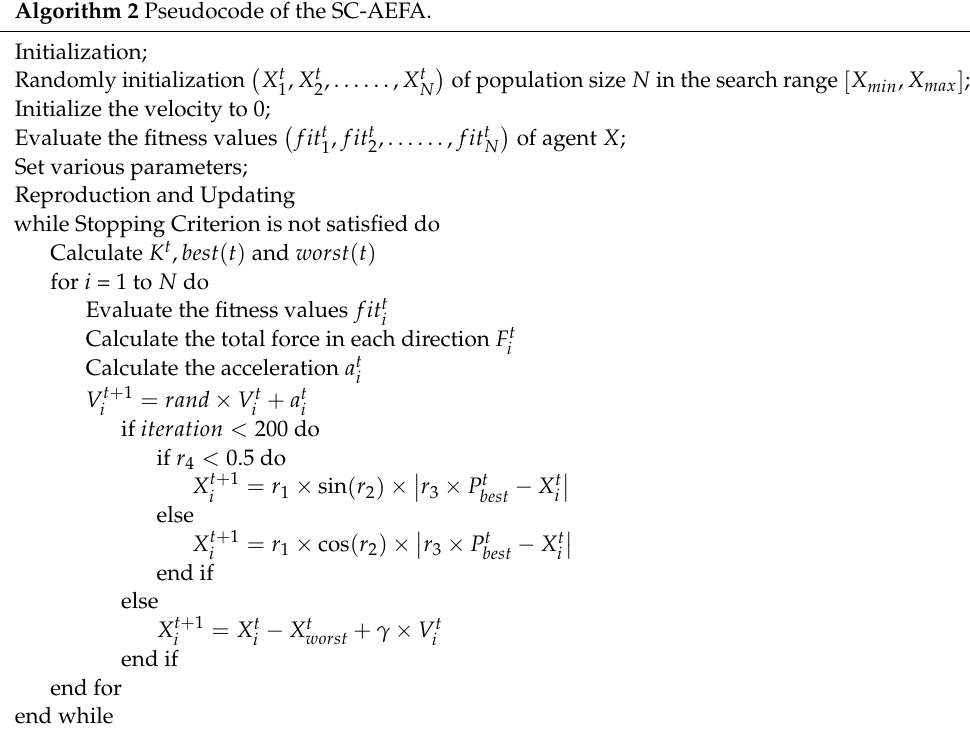
Algorithm 2 Pseudocode of the SC-AEFA.